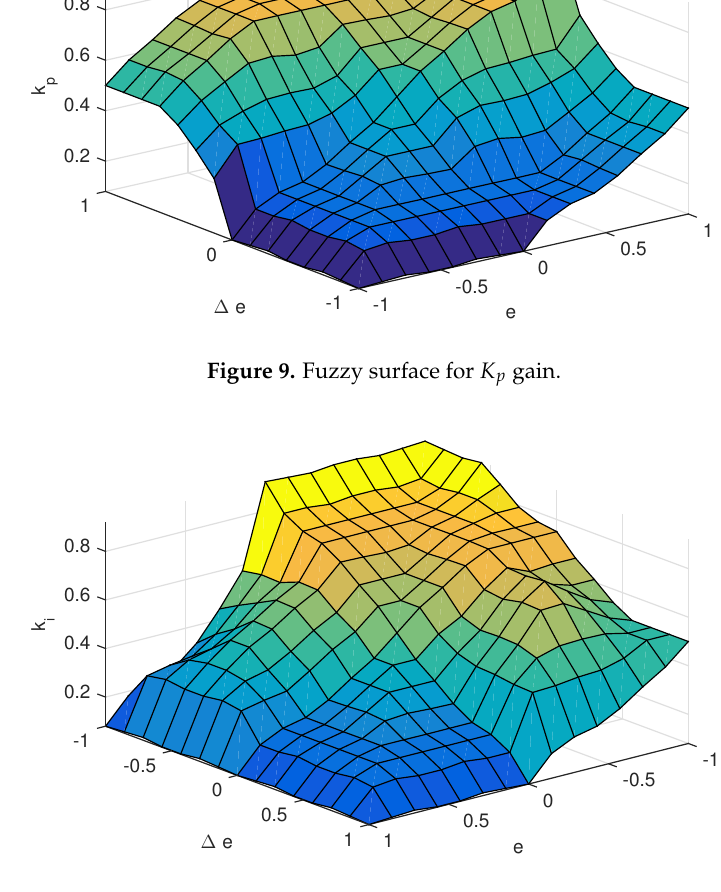
Figure 10. Fuzzy surface for K i